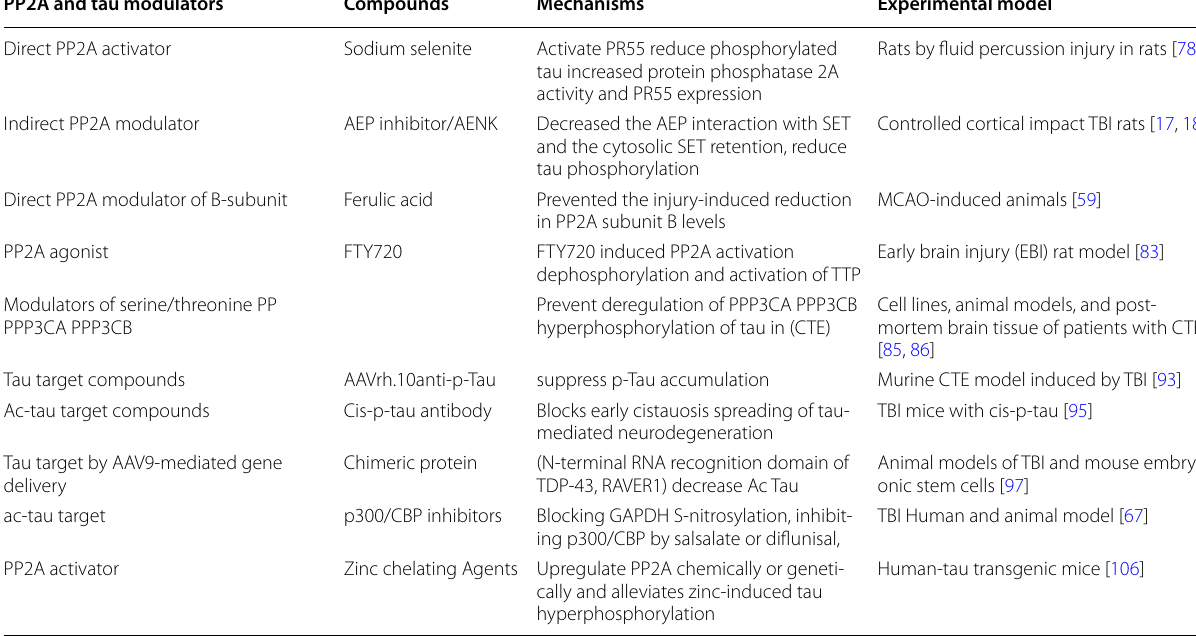
Table 1 PP2A Tau cascade modulators and their mechanism of action PP2A and tau